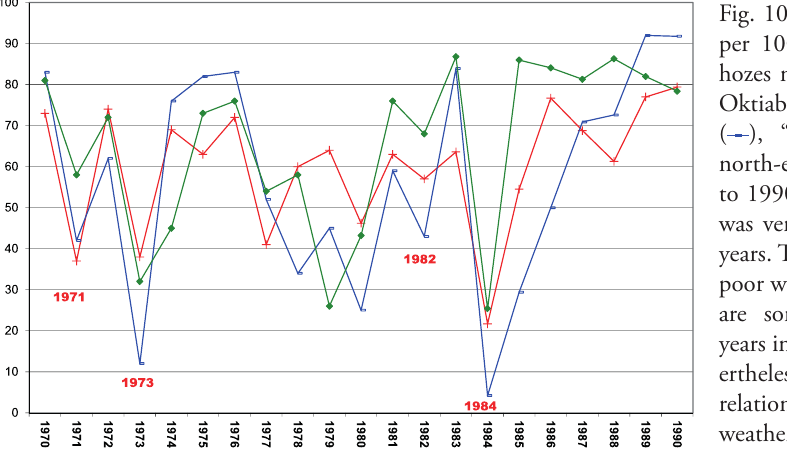
Fig. 10. The number of